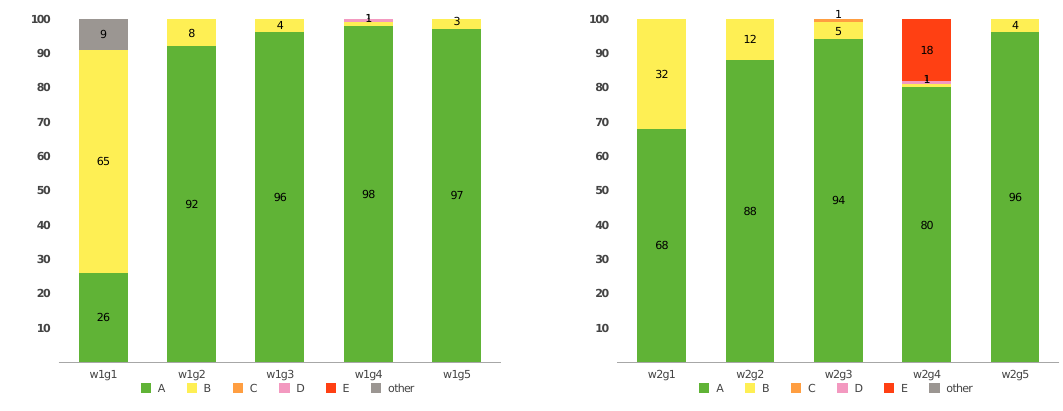
Figure 1. Categorization into Classes (A)~(E) of 100 simulation results for the Width 1 (w1) (left) and w2 (right) source models,